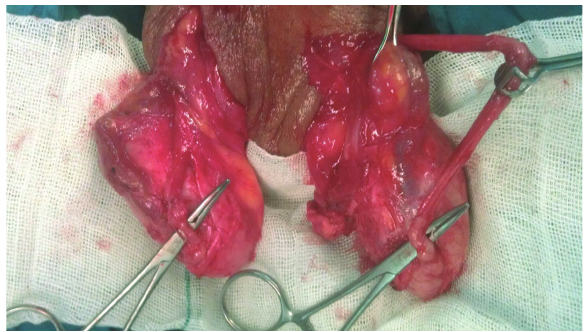
Figure 2 - Bilateral epididmal